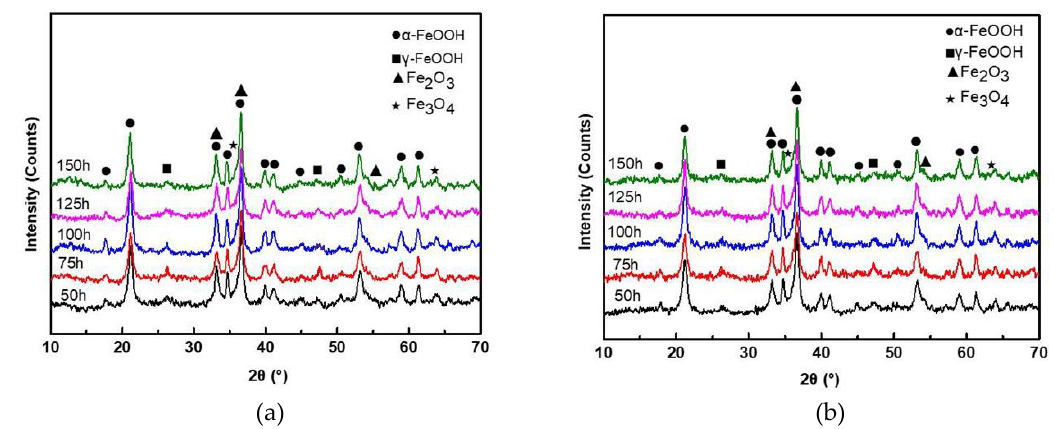
Figure 4. XRD patterns of rust layers formed on ( a ) SMA490BW steel and ( b ) welded joints after the periodic immersion wet/dry cyclic corrosion test.